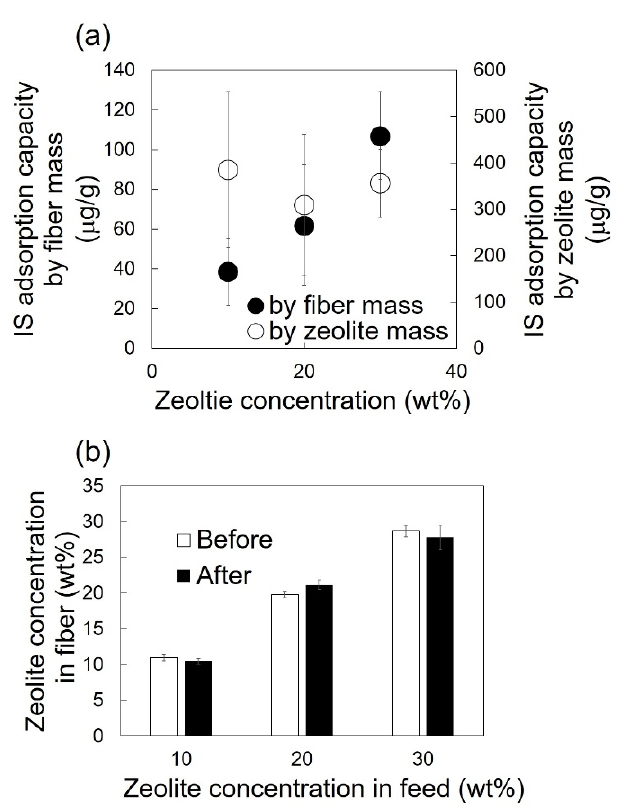
Figure 4. ( a ) The IS adsorption capacity of 7H240 zeolite/EVOH nanofiber mesh after the adsorption test at 37 °C for 24 h. The adsorption capacity was calculated by the fiber mass (black circles) and zeolite mass in the nanofiber mesh (white circles) ( n = 3). ( b ) The zeolite concentration of the 7H240 zeolite/EVOH nanofiber mesh before and after water immersion test according to TGA ( n =